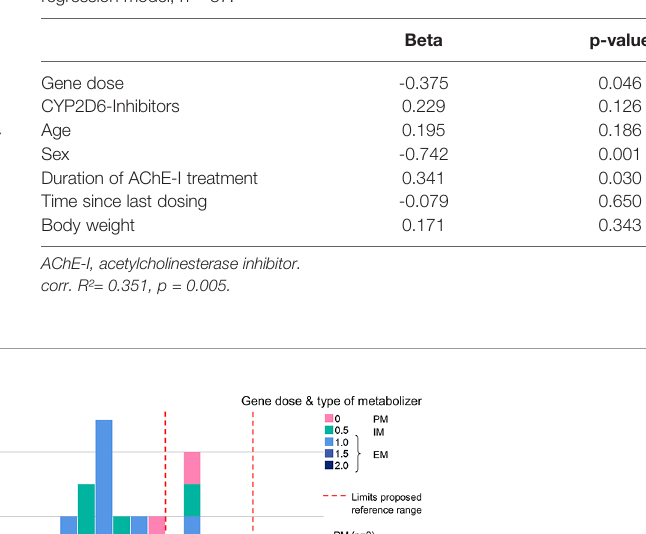
Table 1 . Serum concentration in relation to gene dose and type of metabolizer is displayed in Figure 1 .